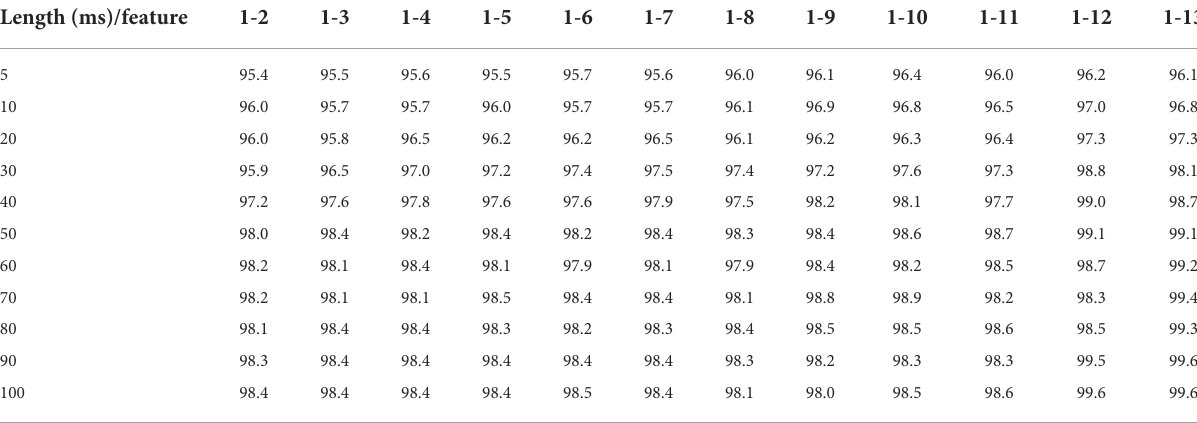
TABLE 4 LSTM-based PHRC state recognition (Group 2 features; %). Length